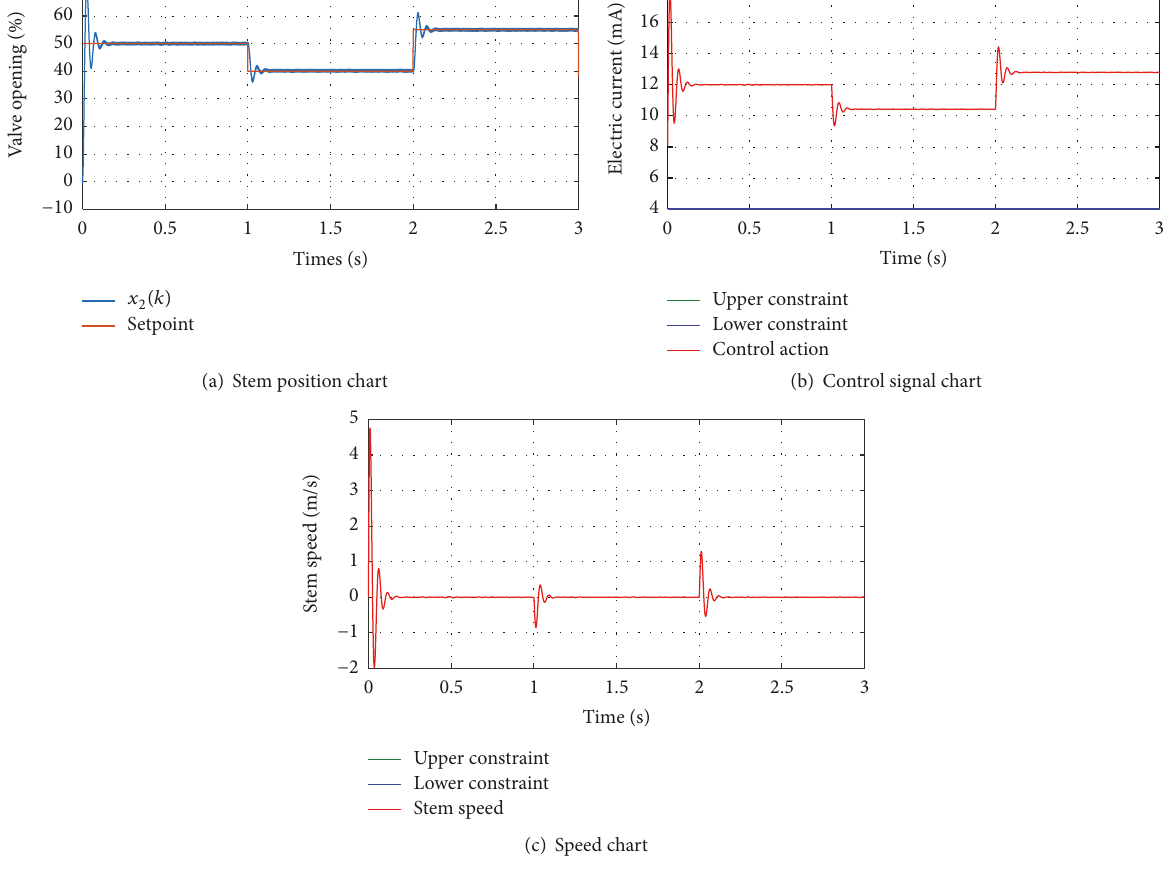
Figure 4: Simulation 1.